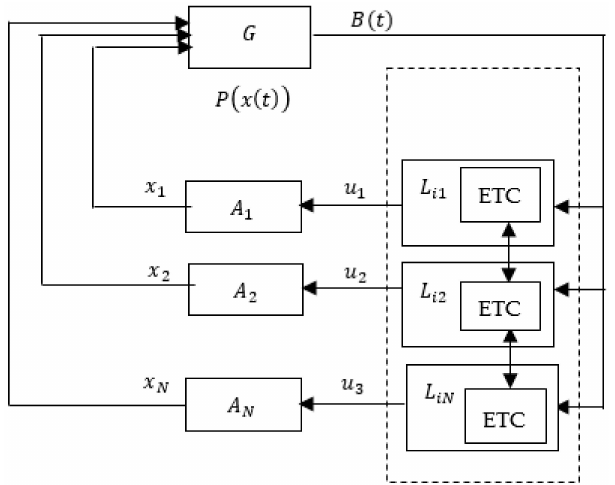
Figure 3. Event-triggered broadcast controller